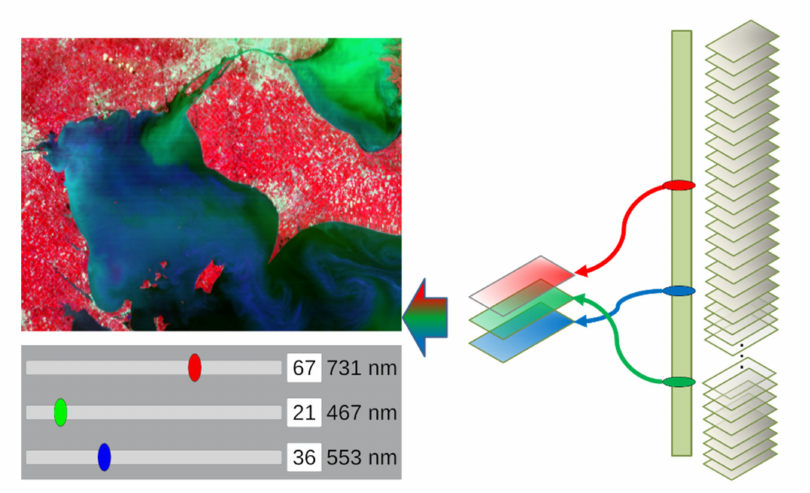
Figure 10. Implementation of the RGB viewer (Source: